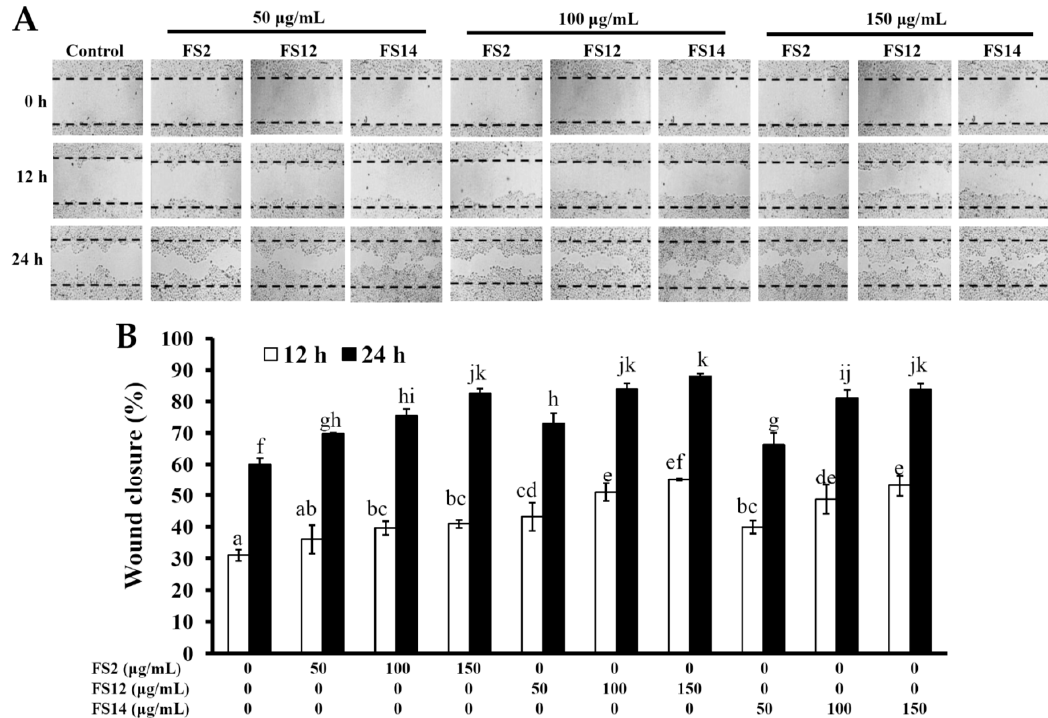
Figure 4. Effects of FS2, FS12, and FS14 on wound healing of HaCaT cells. ( A ) HaCaT cells were treated with different concentrations of FS2, FS12, and FS14, after incubation at 37 °C for 12 and 24 h, and the wound-healing activity was assessed. ( B ) The bar graph summarizes the three wound healing experiments and shows the percentage of wound closure for FS2, FS12, and FS14 at different concentrations and different time intervals. The data are represented as means ± SD ( n = 3). Bar values having different letters (in a, b, c, d, e, f, g, h, i, j, and k) indicate significantly different ( p < 0.05).